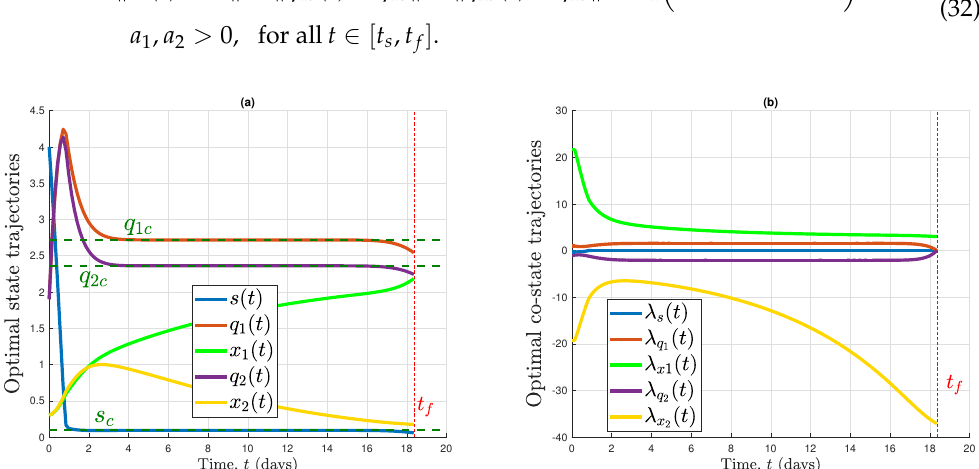
Figure 3. ( a ) Optimal state in Droop model, ( b ) the resulting optimal co-state trajectories, which satisfy in particular all the transversality conditions of the